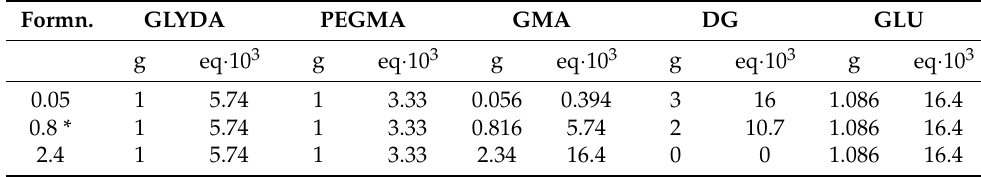
Table 2. Formulations to test the effect of GMA.